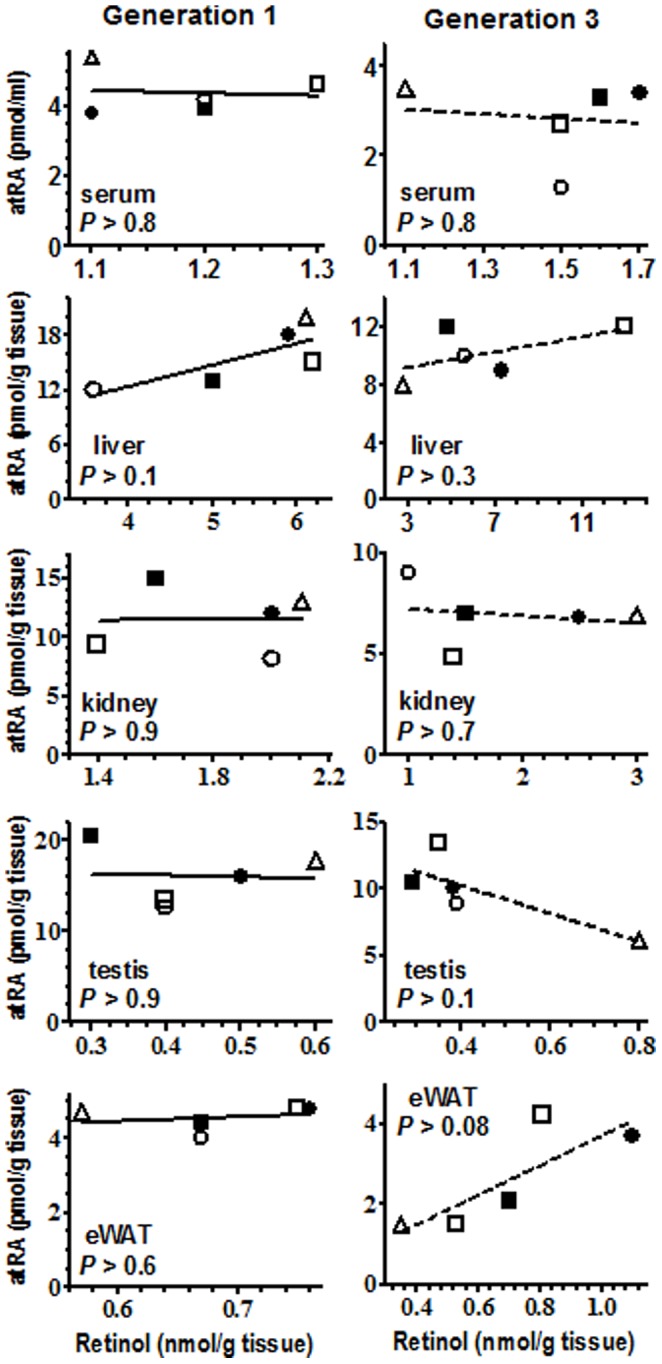
Relationships between retinol and atRA.Retinol (x-axis) and atRA (y-axis) values for serum and tissues from first generation (left column) and third generation (right column) fed a VAS (eWAT, epididymal white adipose tissue): □, C3H; Δ, AKR; ▪, 129; •, C57; ◯, BALB. Linear regression analysis for each tissue and generation verified that none of the slopes differed significantly from zero.